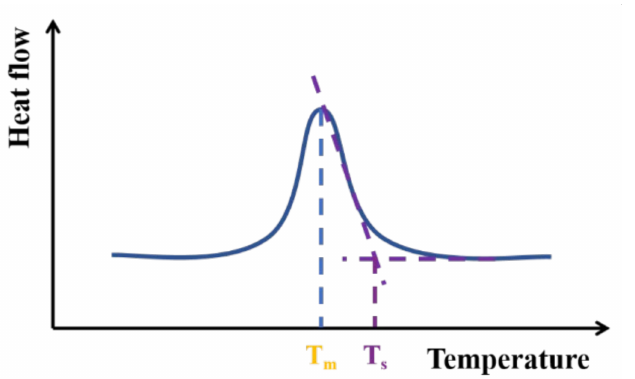
Figure 3. Geometrical relationship between the onset crystallization temperature ( T s ) and the maxi- mum crystallization temperature ( T m